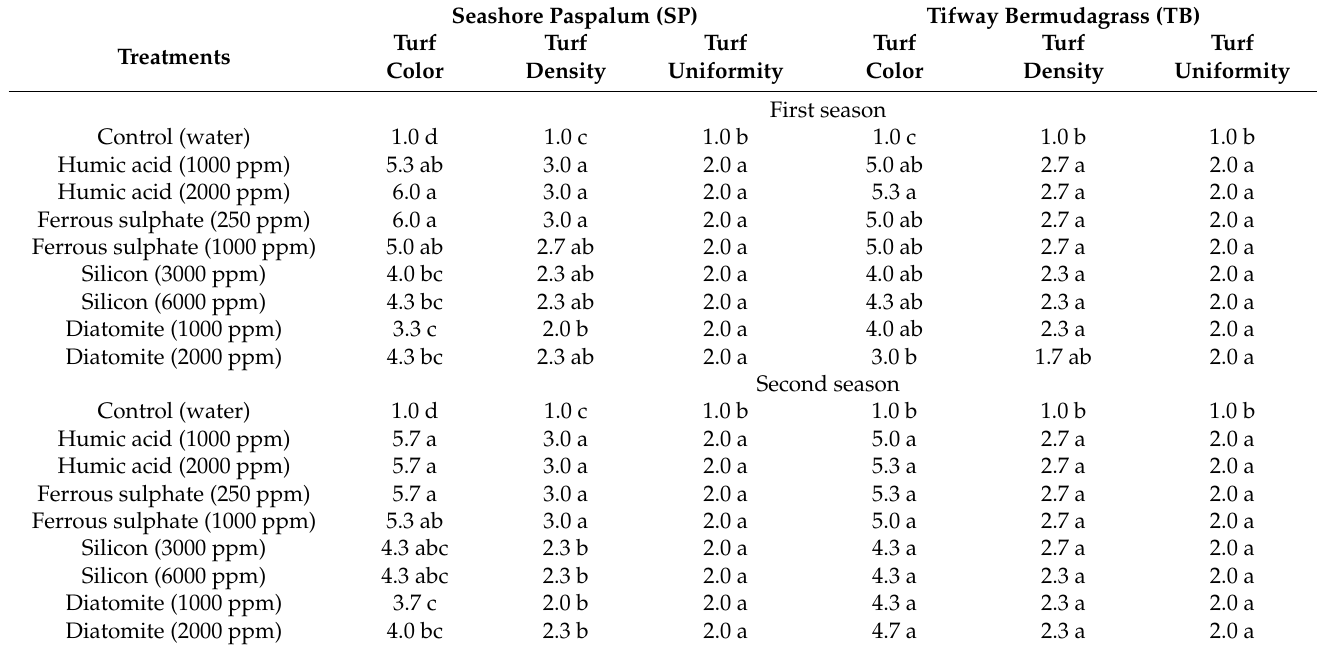
Table 4. Visual turf color score, turf density, and turf uniformity in seashore paspalum and Tifway bermudagrass treated with different amendments (area used for measuring was 100 cm 2